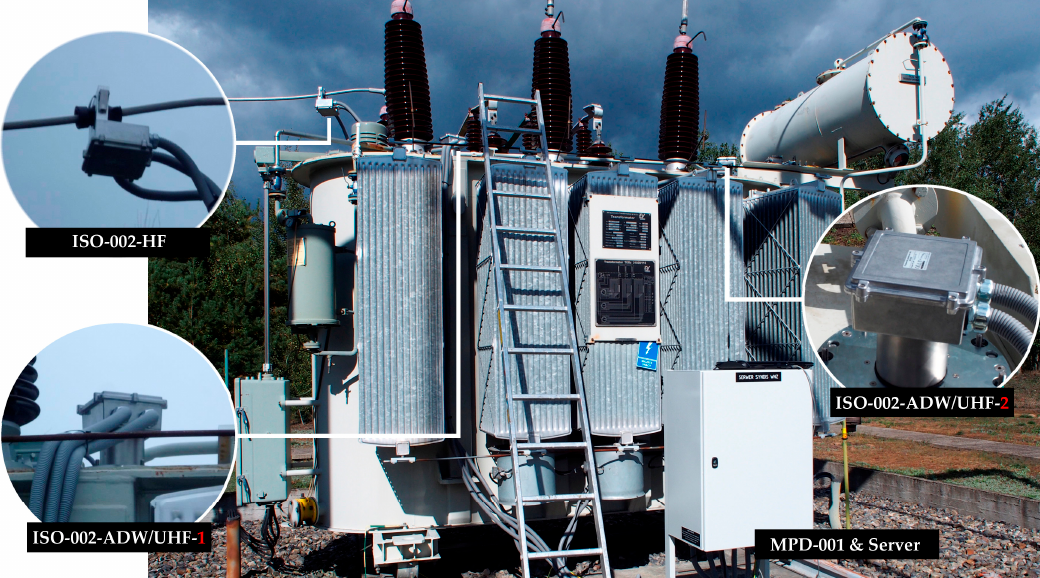
Figure 31. Photograph of the PD on-line monitoring system installed on 31.5 MVA substation power transformer.